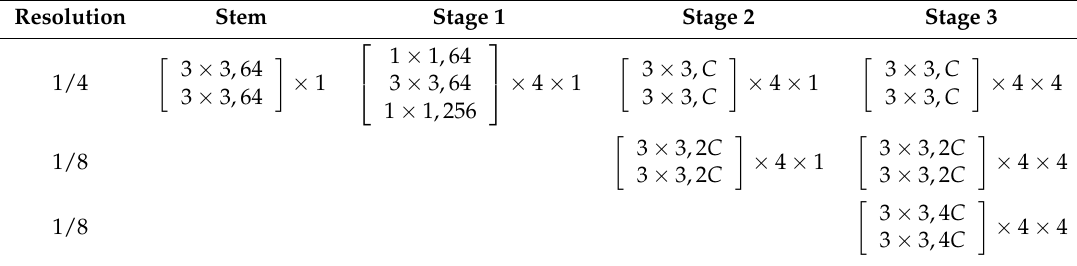
Table 1. Architectures of our backbone network for Siamese-based trackers. There are three stages in total. In this table, each cell contains three components: the first [ ] is a residual unit, the second and third numbers means the repetition times of the residual units and the modualized blocks, respectively. For clarify, the fusion unit is not described. C in each residual unit is the number of